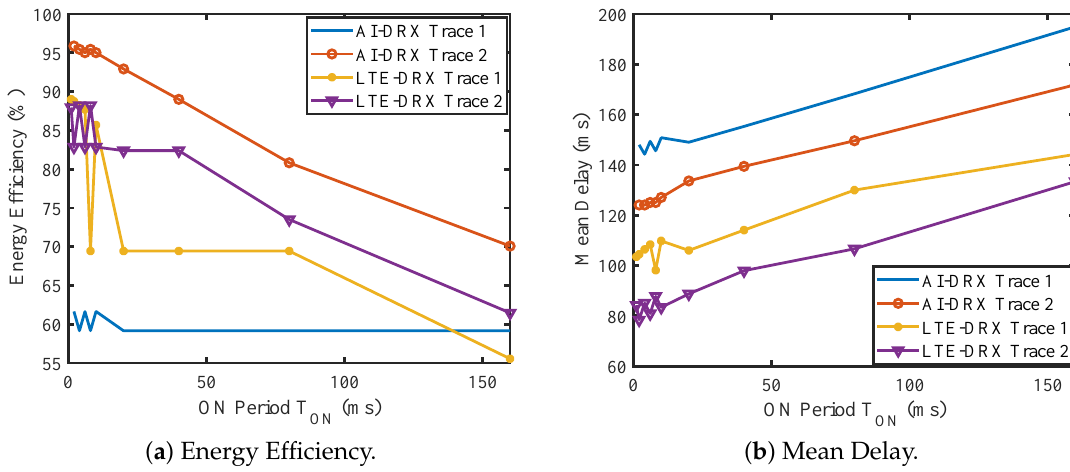
Figure 12. AI-DRX energy efficiency and mean delay with varying T ON ( Th Min = 300, Th Max = 1600).